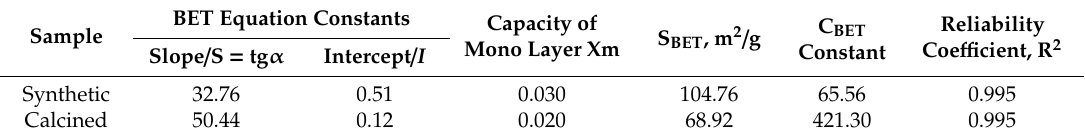
Table 2. Data of Σ A and Σ V P calculations of